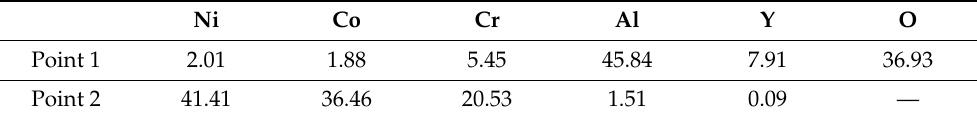
Figure 1. Sectional image of the TBCs sample captured by ( a ) super-depth microscope and ( b ) SEM. Table 1. Content of different elements at the two points in Figure 1 (wt.%).